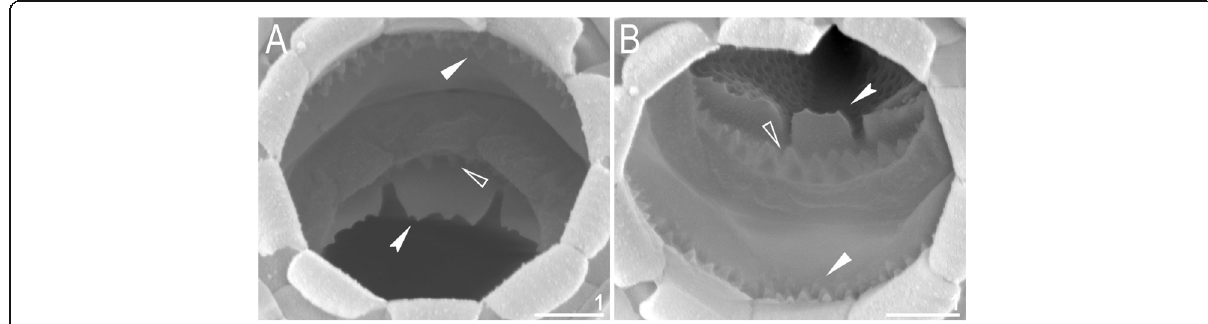
Fig. 26 Macrobiotus ripperi sp. nov. from Poland (PL.015) – the oral cavity armature seen with SEM: a – b – the oral cavity armature of a single specimen seen with SEM from different angles showing dorsal and ventral portion, respectively. Filled flat arrowheads indicate the first band of teeth, empty flat arrowheads indicate the second band of teeth, and filled indented arrowheads indicate the third band of teeth. Scale bars in μ m